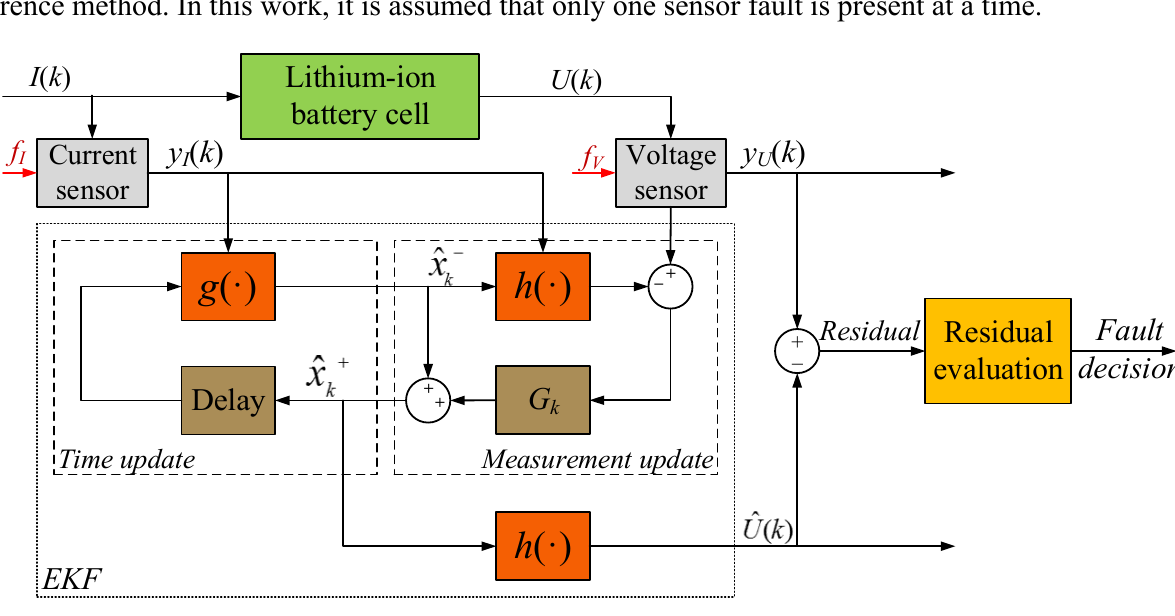
Figure 2. Schematic of the proposed fault